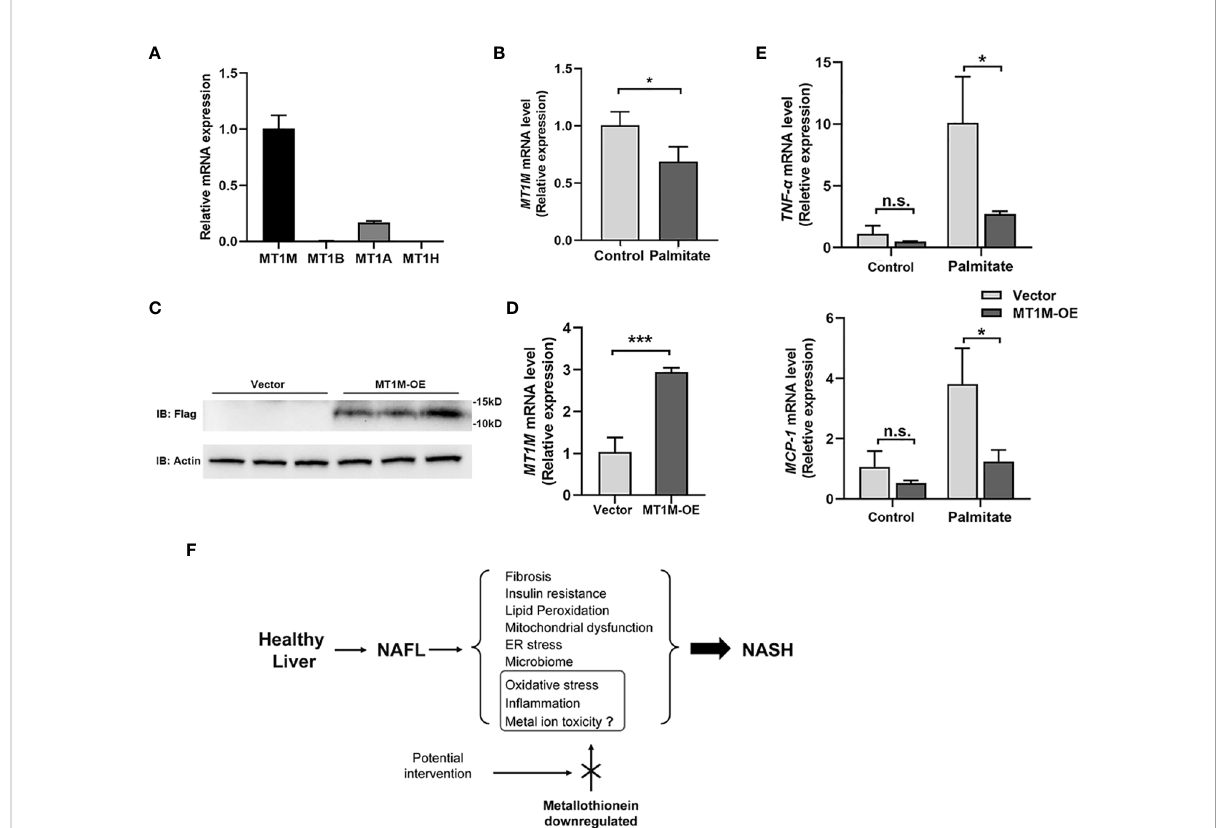
FIGURE 6 MT1M inhibits in fl ammation in Huh-7 cell exposure to palmitic acid. (A) The endogenous gene expression of MT1M, MT1B, MT1A, and MT1H in Huh-7 cells. (B) MT1M expression of Huh-7 cells treated with palmitate (250 m M, 12 h). (C) Veri fi cation of MT1M over-expression (MT1M-OE) ef fi ciency in Huh-7 cells by western blot. (D) Veri fi cation of MT1M-OE ef fi ciency in Huh-7 cells by RT-PCR. (E) Expression of TNF a and MCP1 was measured by RT-PCR from vector or MT1M-OE Huh-7 cells treated with or without palmitate (250 m M, 12 h). Data are shown as mean ± SEM. * p < 0.05, *** p < 0.001. “ n.s. ” means no signi fi cance. (F) Proposed working model of MT in the regulation of NASH progression. MT, metallothionein; NASH, non-alcoholic